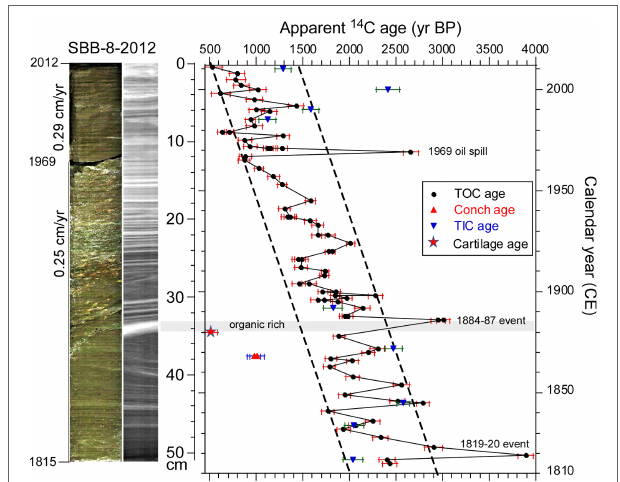
FIGURE 4 | The measured 14 C ages of all samples in Core SBB-8-2012. The two parallel dashed lines indicate the envelope of general variations of the measured 14 C ages on total organic carbon in the sediments except for three outstanding